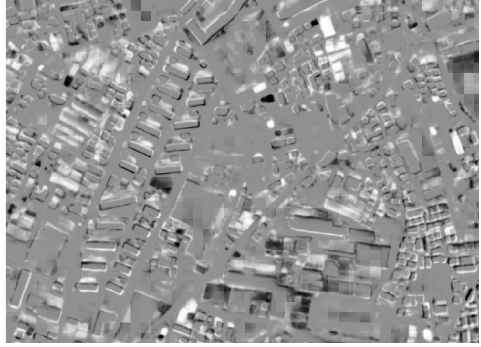
Figure 12. Difference extraction via subtraction distance